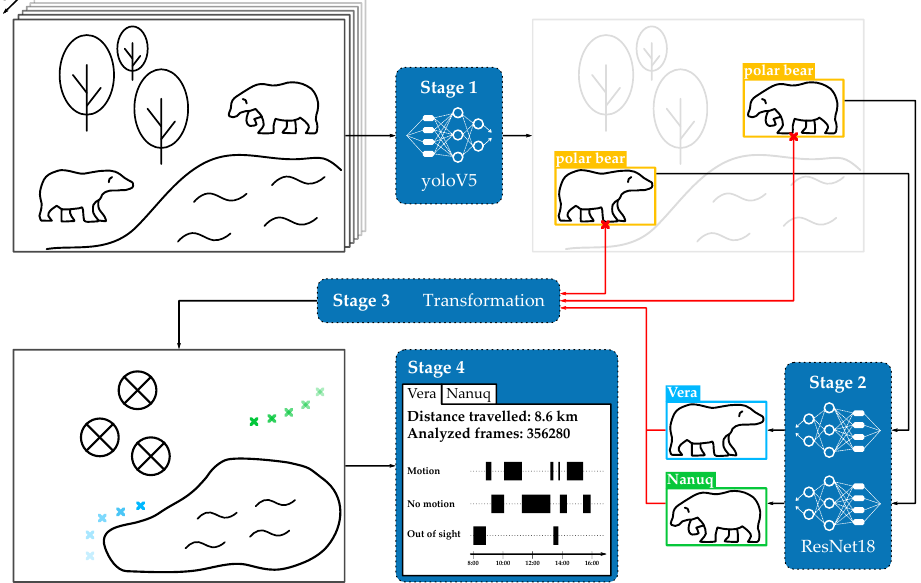
Figure 1. A high-level overview of the proposed framework. It takes raw videos as input and outputs labeled trajectories as well as basic statistics of the observed animal behavior. There are 4 major stages: animal detection (1) , classification of individuals (2) , coordinate transformation (3) from the image plane to the enclosure map and finally a basic analysis (4) of the